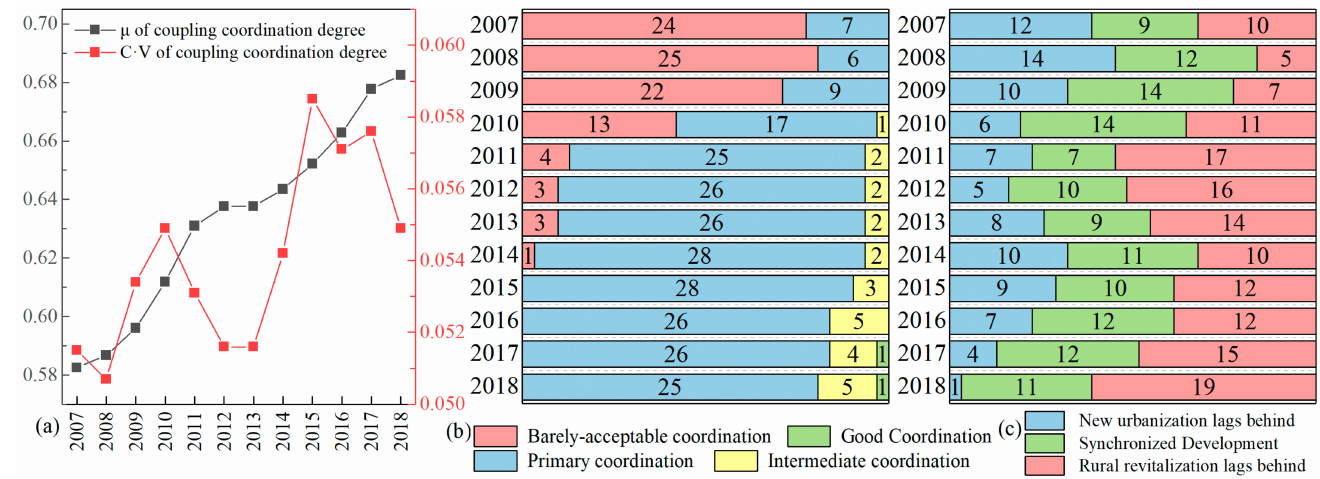
Figure 5. ( a – c ) Characteristics and types of coupled coordinated degree during 2007–2018. (Source: made by